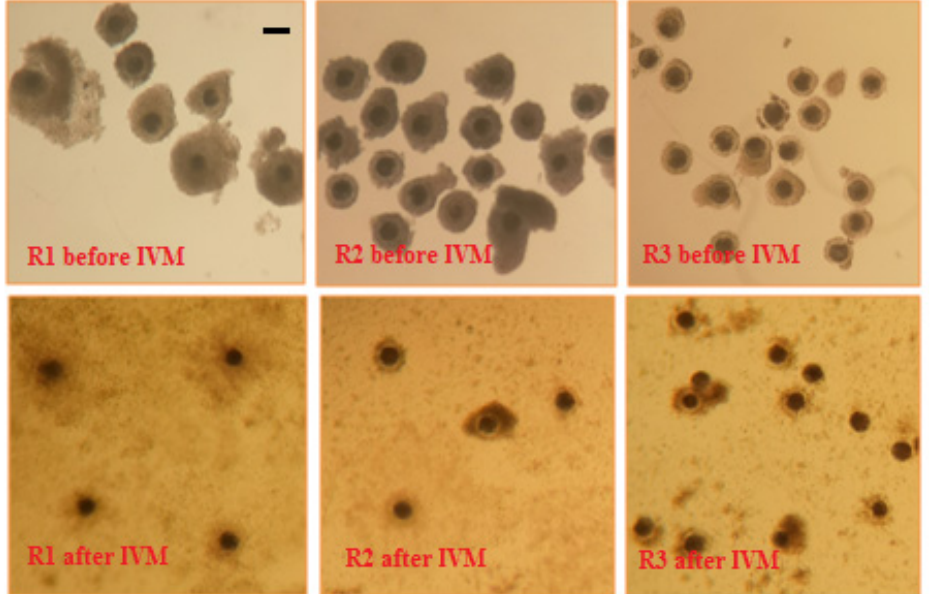
Figure A2. Aspects of porcine oocytes from rosmarinic acid group (R) classified according to their morphological aspects (class 1, 2 or 3) before and after IVM. Scale bar represents 100 µm. The scale bar is applicable to all panels (3.2X).